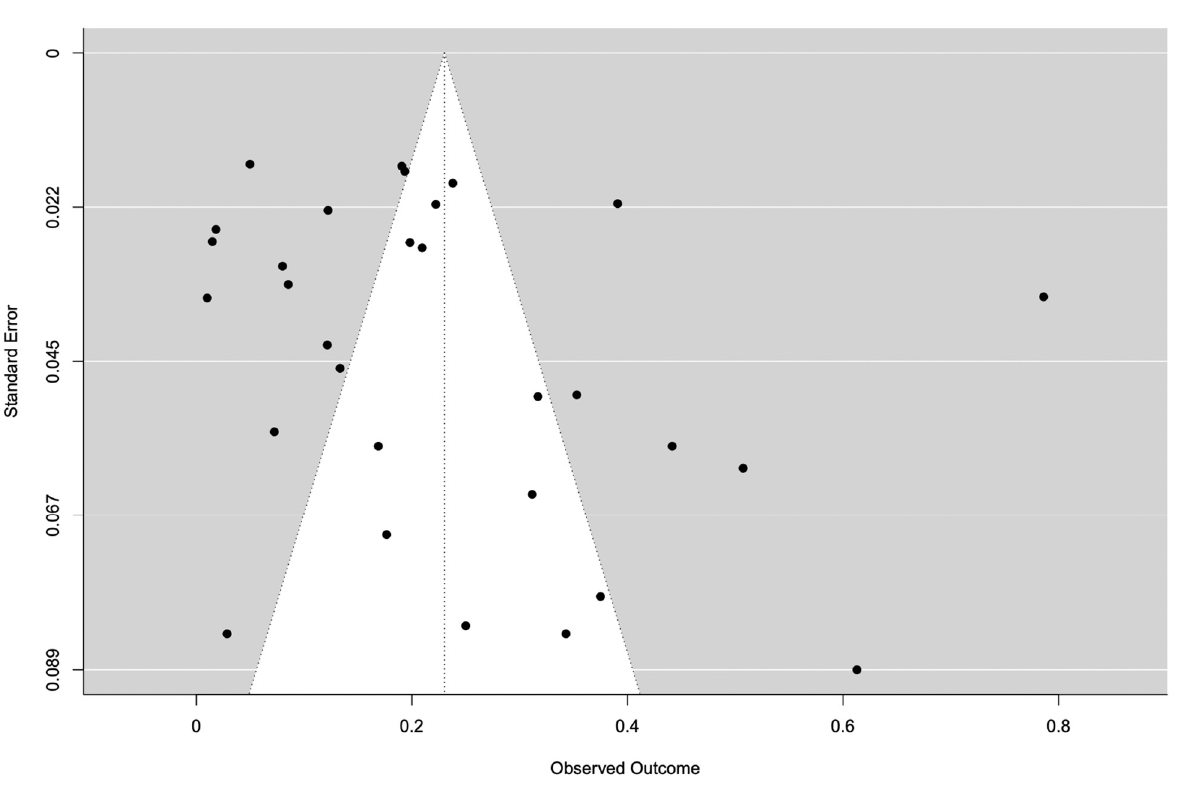
Figure 4. Contour-enhanced funnel plot. The funnel is centred at 0. Various levels of statistical significance of the points, representative of the studies, are indicated in the plot.